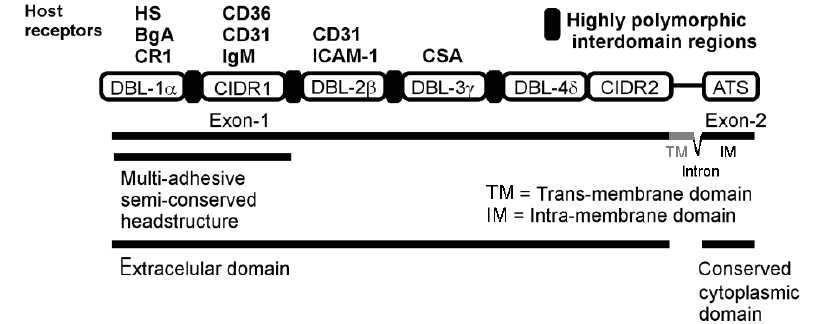
Fig. 4 – Schematic representation of the PfEMP1 structure showing host receptors and domains (http://sites.huji.ac.il/malaria/maps/PfEMP1.html). Host receptors: HS (heparan sulfate), BgA (Blood group A), CR1 (complement receptor 1), CD36 (cluster of differentiation 36), CD31 (cluster of differen- tiation 31), IgM (immunoglobulin M), ICAM 1 (intercellular adhesion molecule 1), CSA (chondroitin- 4-sulfate). PfEMP1 domains: DBL (Duffy binding-like), CIDR (cysteine rich interdomain region), ATS (acidic terminal segment). Structure of the var genes (exon 1, intron, exon 2) is shown below